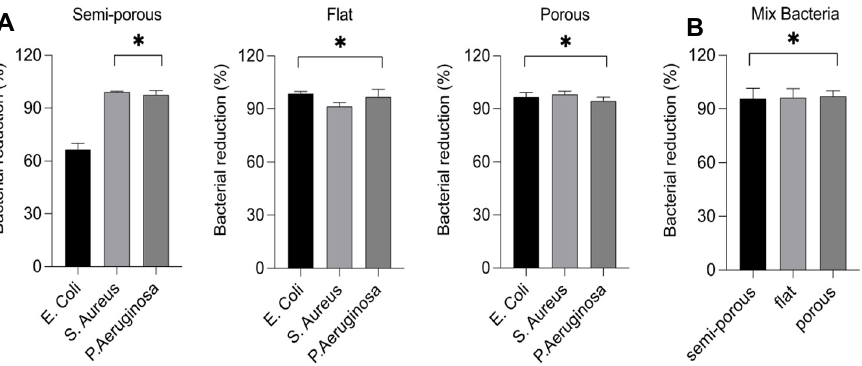
Figure 5. Bactericidal effect of HOCl solution at 300 ppm against E. coli , S. aureus and P. aeruginosa 1 × 10 6 CFU/mL. The bacteria were incubated in the different surfaces—semi porous, flat and porous. Data represent the percentage of bacterial reduction after 10 min of exposition of nebulization. ( Panel A ) shows the single reduction of microbial growth on different surfaces, while ( panel B ) shows the reduction growth of a mix of microorganisms. Values were obtained by comparing the results with the bacteria control. Data represent the mean of three independent experiments conducted in triplicate. * p < 0.05. Table 1. The table shows the percentage of inhibition growth of individual microorganisms on different surfaces, after nebulization with HOCl at 300 ppm. All the data reported are the average of three independent experiments conducted (each experiment) in triplicate. E. coli (R%) P. aeruginosa (R%) Semi-porous nebulized Flat nebulized